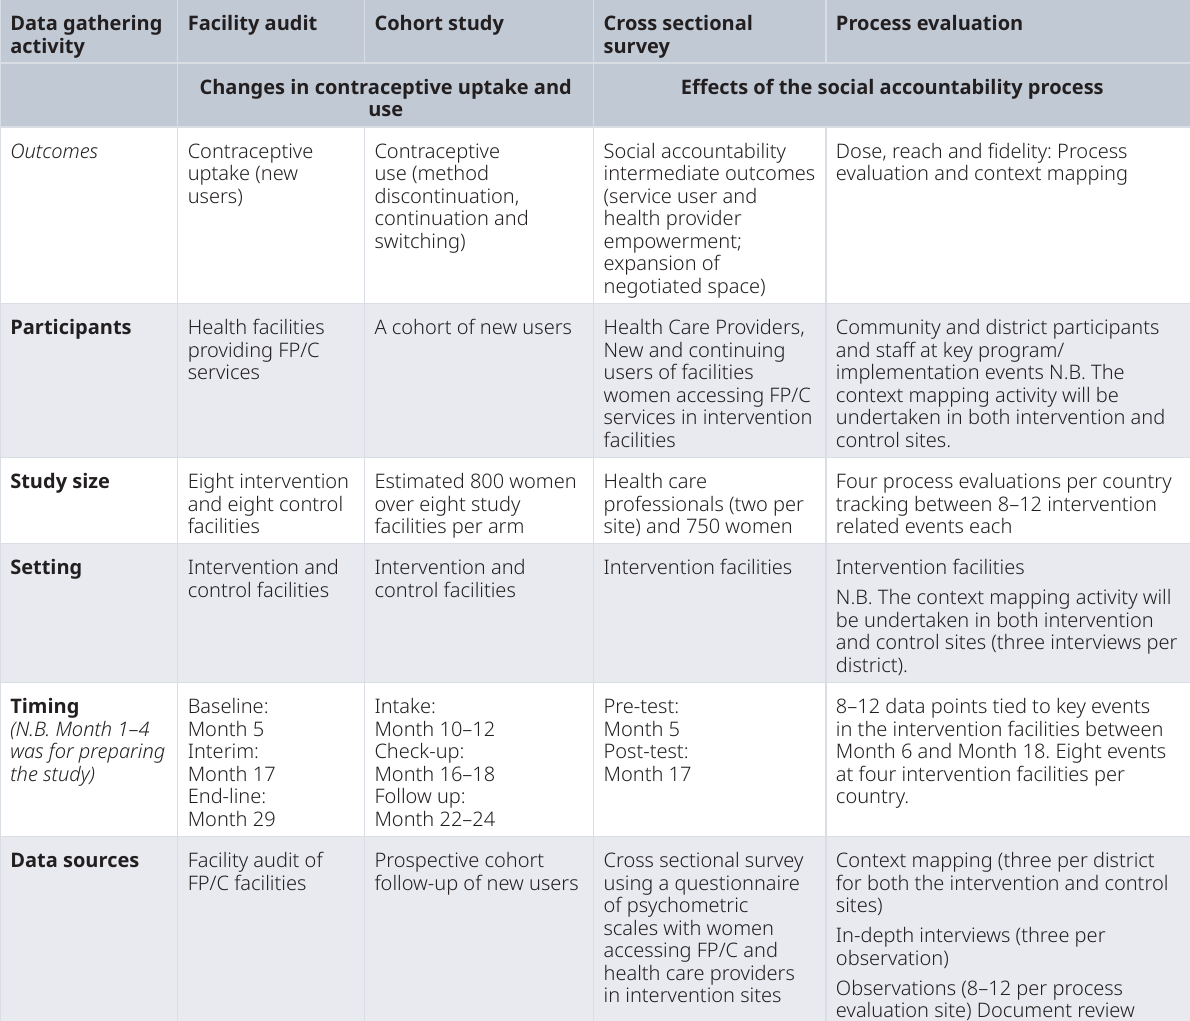
Table 3. Study overview